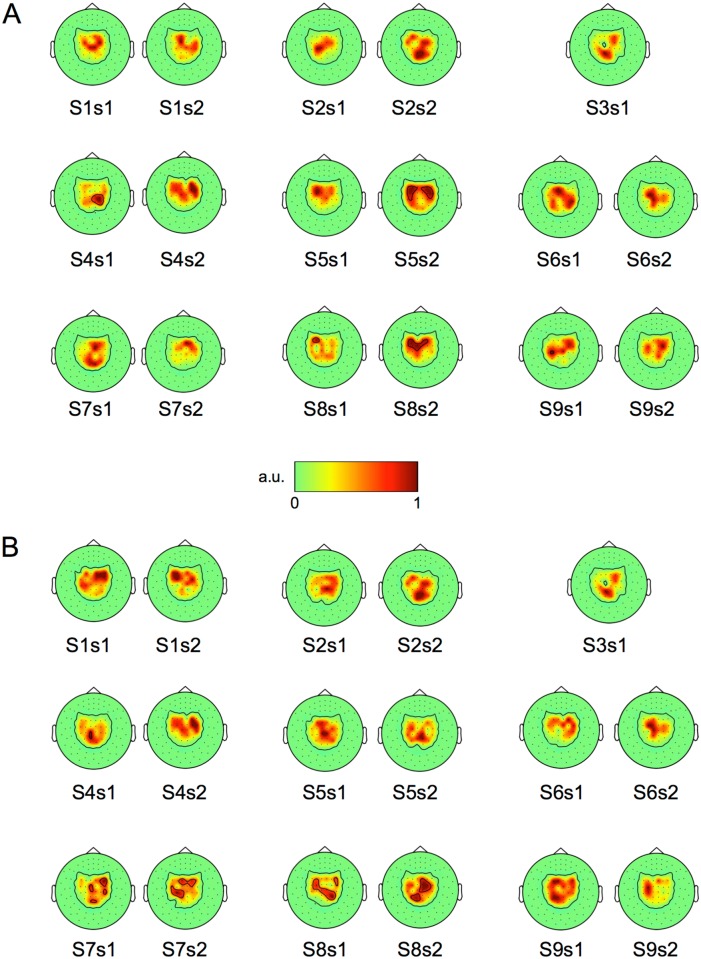
Spatial patterns of the CSP components showing the highest 10/20-Hz suppression for each subject (S) and session (s).Components showing the highest (A) alpha-band and (B) beta-band suppression during MI. The scale is normalized to 0–1 (arbitrary units) for clarity. The outermost black contour lines show the outline of non-zero values.